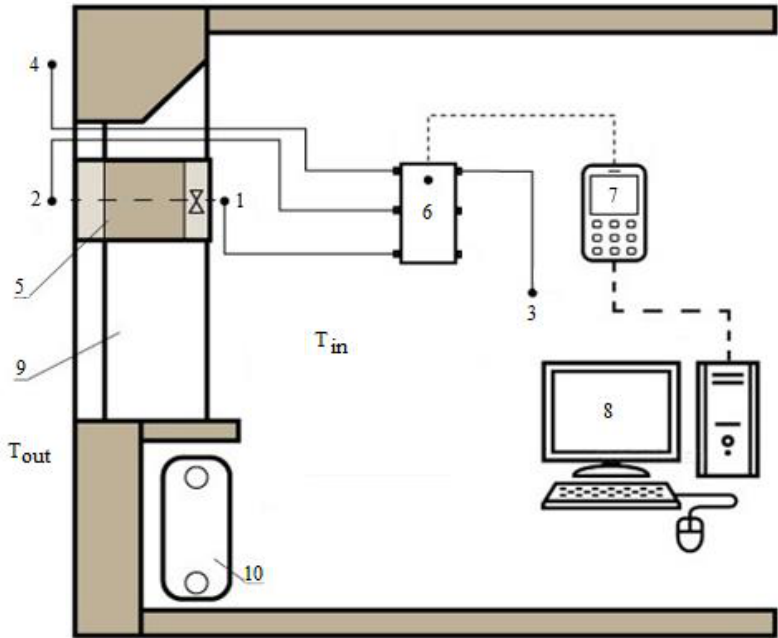
Figure 3. Schematic diagram of the experimental installation “SSRHE Temperature Conditions Research”: 1–4: air temperature sensors; 5: SSRHE; 6: sensor connection module; 7: temperature re- corder; 8: personal computer; 9: window; 10: room heater.